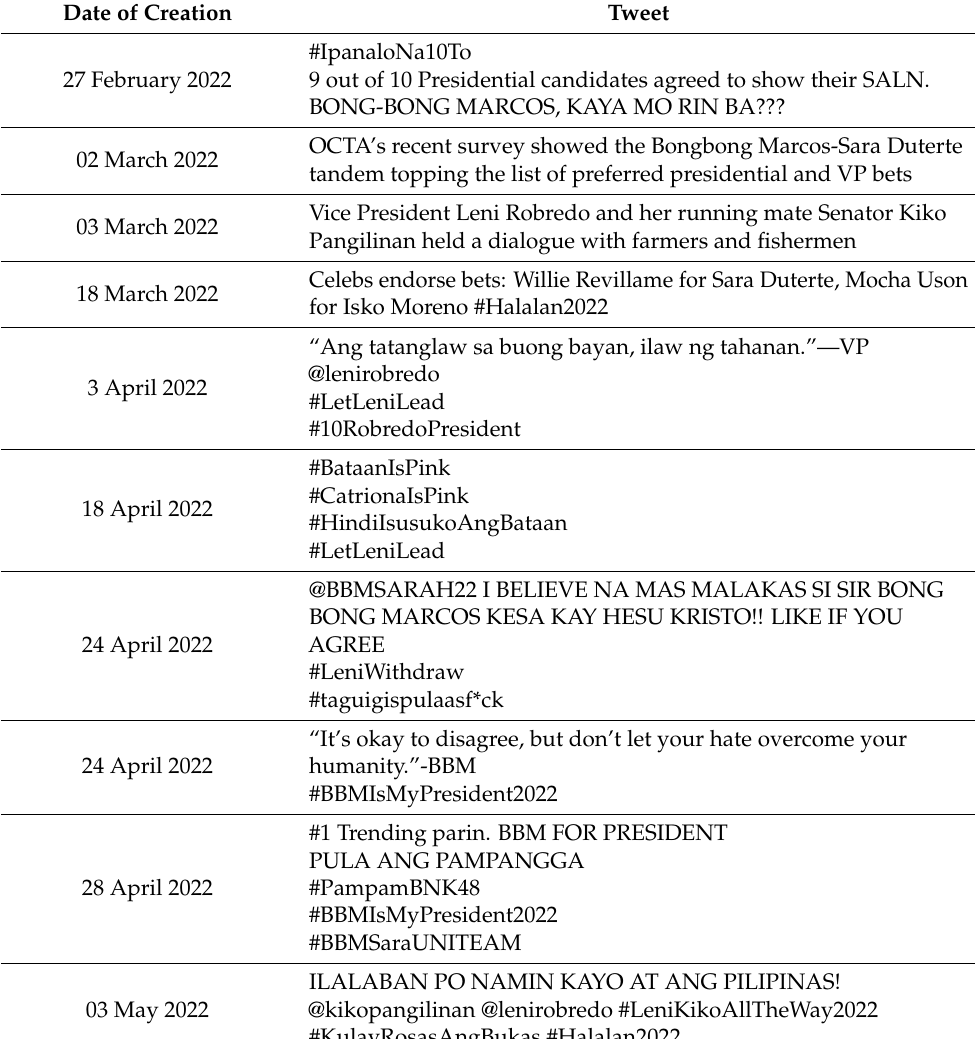
Table 2. Some of the raw tweets extracted from tweepy